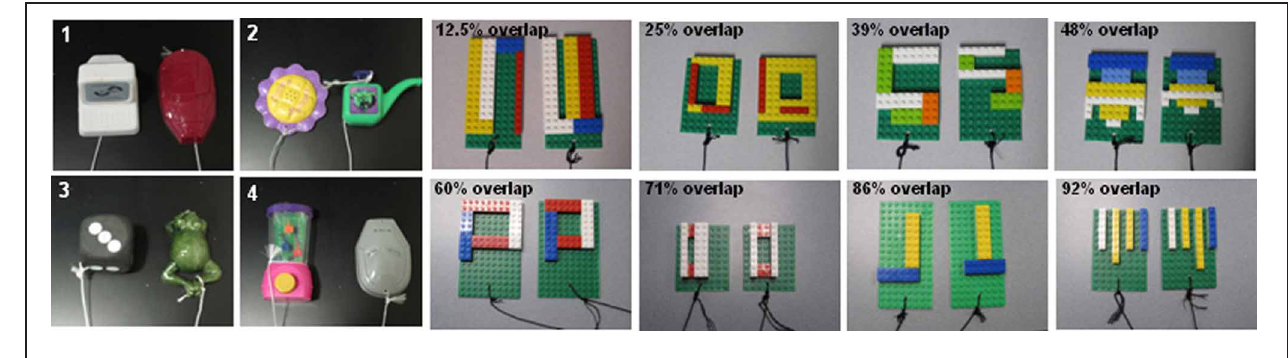
FIGURE 6 | Test stimuli used of object discrimination in monkeys. 1–4 are examples of the distinctly different objects used in Easy Condition of the Object Discrimination Task.